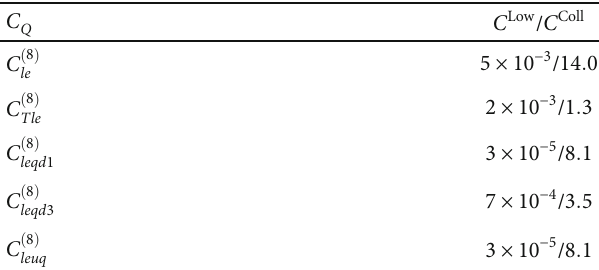
Table 4: The ratio of potential limits from low energy processes and minimum observable values at the collider for the